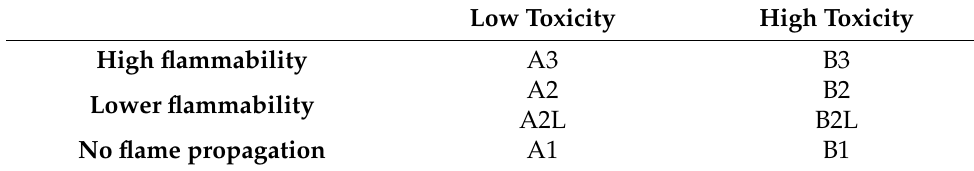
Table 1. Classification of fluids according to ASHRAE 34